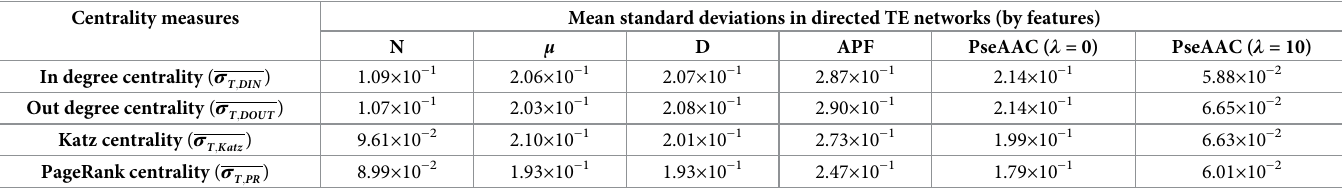
Table 2. The mean standard deviation results for the centralities of directed networks (CATH). Centrality measures